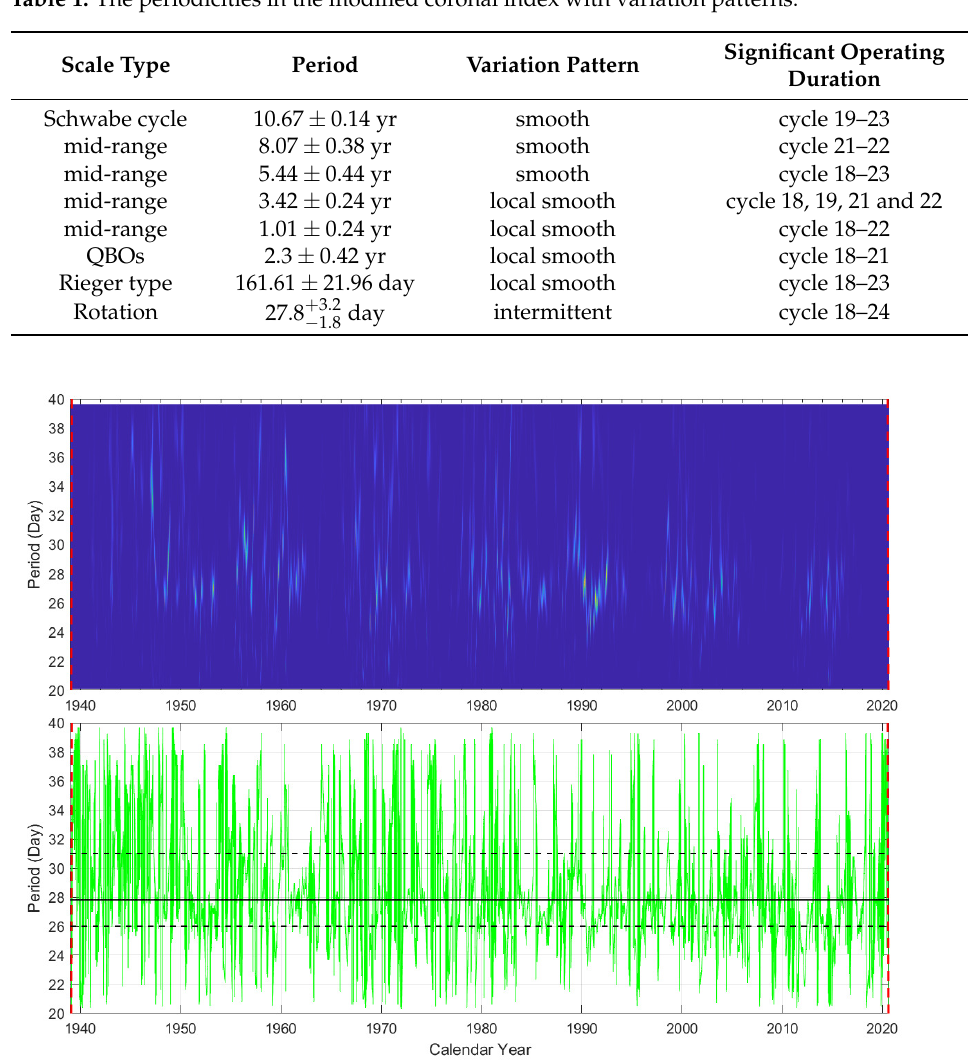
Figure 13. Same as Figure 6, but for periods between 20 and 40-day. In the lower panel, the solid black line presents the median of periods with a value of 27.8-day; the lower and upper dashed black lines indicate the 25th and 75th quantiles of the periods with the value of 26 and 31-day,